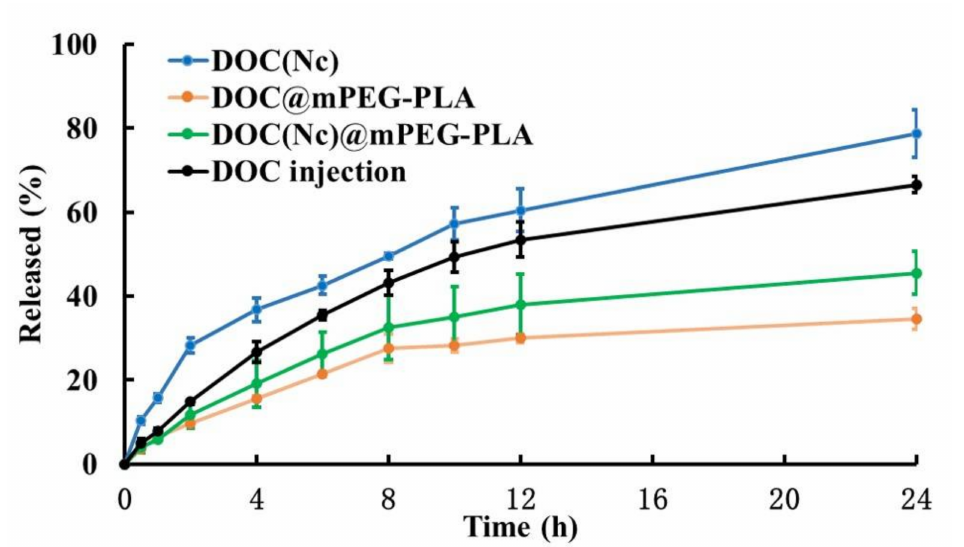
Figure 6. Release profiles of different formulations in a PBS buffer (pH 7.4) at 37 ◦ C ( n =